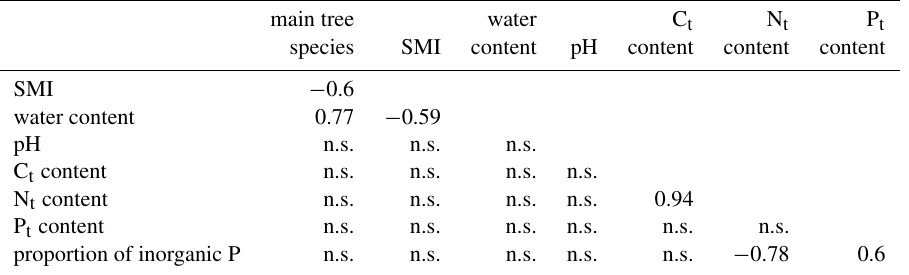
Table 2. Significant Pearson correlation coefficients to reveal correlations between environmental factors, which might affect or be affected by the richness of algae. This co-correlation analysis should support the correct interpretation of potential important factors for the alga community. SMI – silvicultural management index; n.s. – not